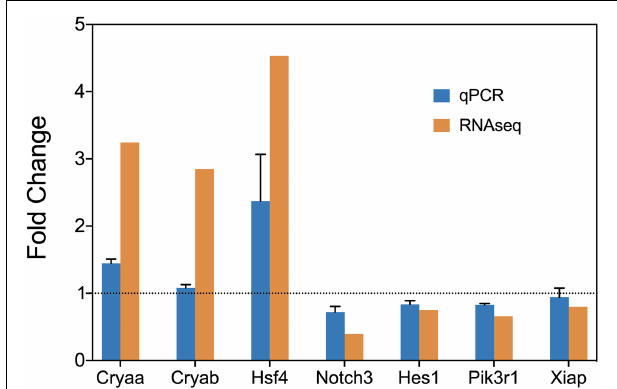
FIGURE 5 | RT-qPCR confirmation of the expression level of Cryaa, Cryab, Hsf4, Notch3, Hes1, Pik3r1, and Xiap.